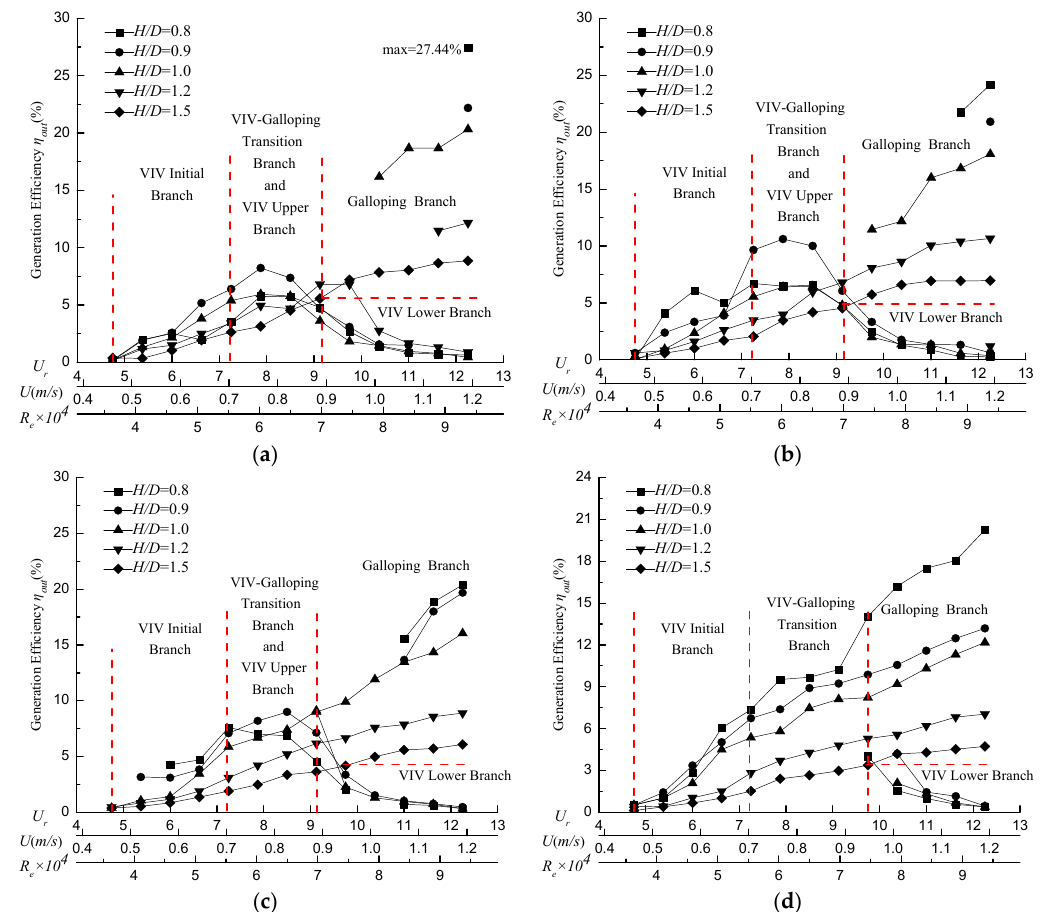
Figure 20. Power generation efficiency with different section aspect ratios at K = 1200 N/m: ( a ) amplitude ratio (4 Ω , ζ = 0.347); ( b ) amplitude ratio (8 Ω , ζ = 0.305); ( c ) amplitude ratio (11 Ω , ζ = 0.246); ( d ) amplitude ratio (16 Ω , ζ = 0.177).